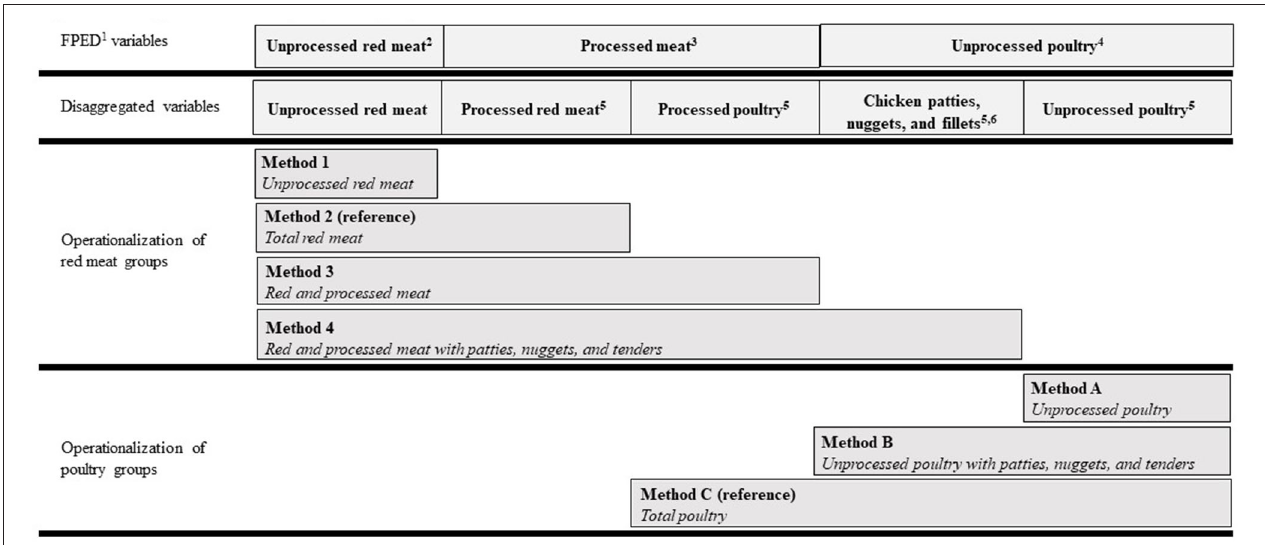
FIGURE 1 | Ontology of red meat and poultry food group methods used in nutrition research. 1 The US Department of Agriculture’s Food Patterns Equivalents Database, available here: https://www.ars.usda.gov/northeast-area/beltsville-md-bhnrc/beltsville-human-nutrition-research-center/food-surveys-research-group/. 2 “Meat” FPED (PF_meat), defined as beef, veal, pork, lamb, and game meat; excludes organ meat and cured meat. 3 “Cured meat” FPED (PF_curedmeat), defined as frankfurters, sausages, corned beef, cured ham and luncheon meat that are made from beef, pork, or poultry. 4 “Poultry” FPED (PF_poult), defined as chicken, turkey, Cornish hens, duck, goose, quail, and pheasant (game birds); excludes organ meat and cured meat. 5 Disaggregated from FPED using the Processed Meat Categories SAS program from the US National Cancer Institute, available here: https://epi.grants.cancer.gov/ProcessedMeatCategories/. 6 Considered “further processed” by American Meat Science Association Lexicon, available here: